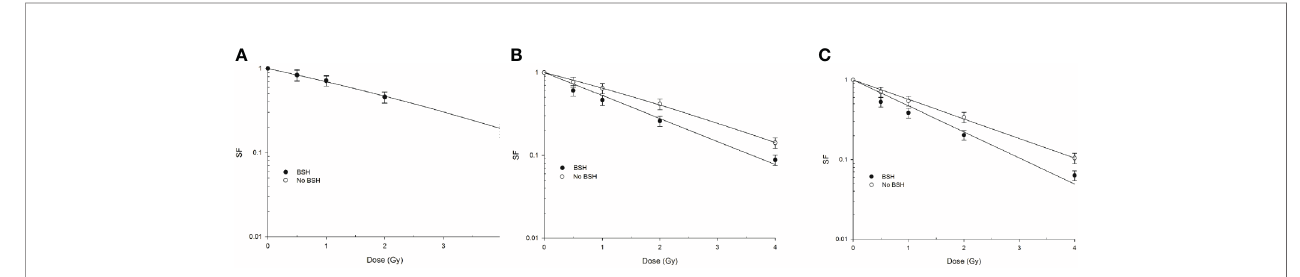
FIGURE 7 | Clonogenic survival of prostate cancer DU145 cells irradiated along the CNAO proton beam SOBP. Effect of the presence or absence of 80 ppm of 11 B from BSH on the survival fraction (SF) in three positions: Left panel (A) entrance, (B) mid SOBP, and right panel (C) distal. Error bars depict SE of at least three independent replicates. Data were fi tted to a linear-quadratic function SF=exp-( a D+ b D 2 ).